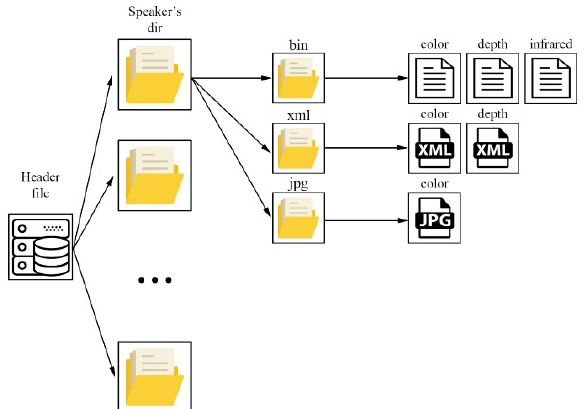
Figure 1. The logical structure of the database of 3D gestures of Russian sign